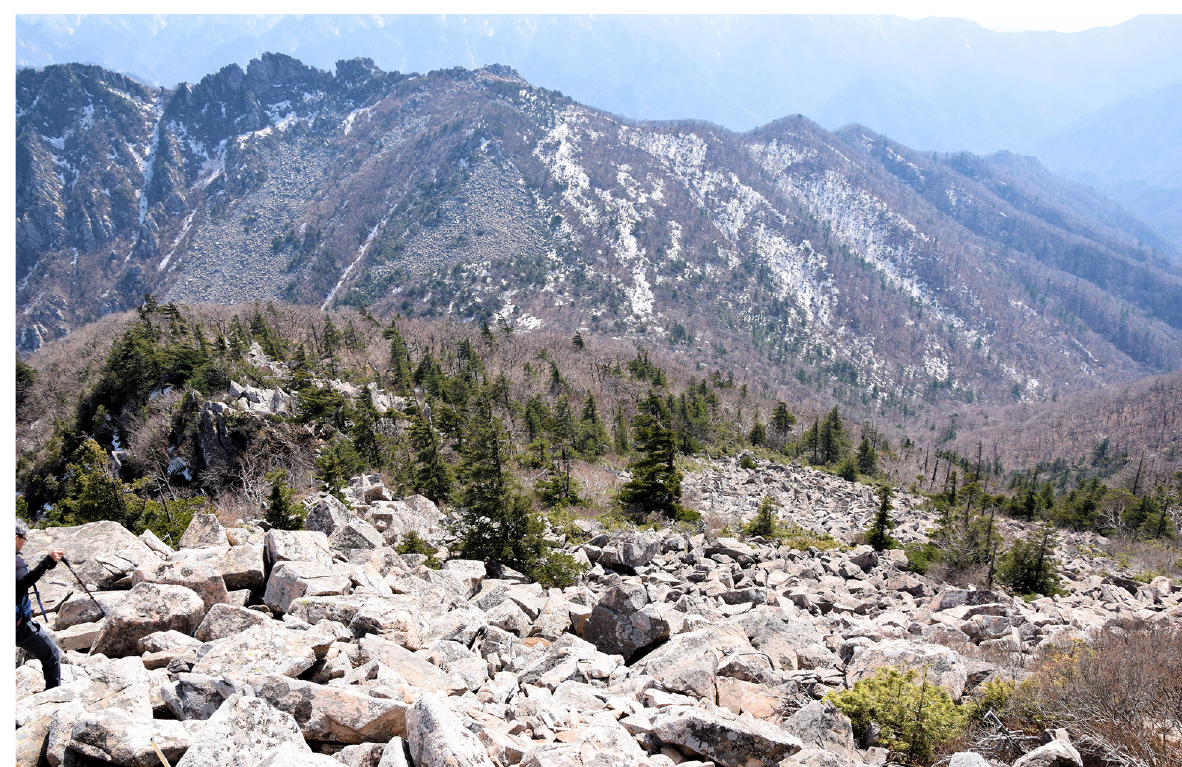
Fig. 7. Block fields on Hwangcholbong (Photo P.